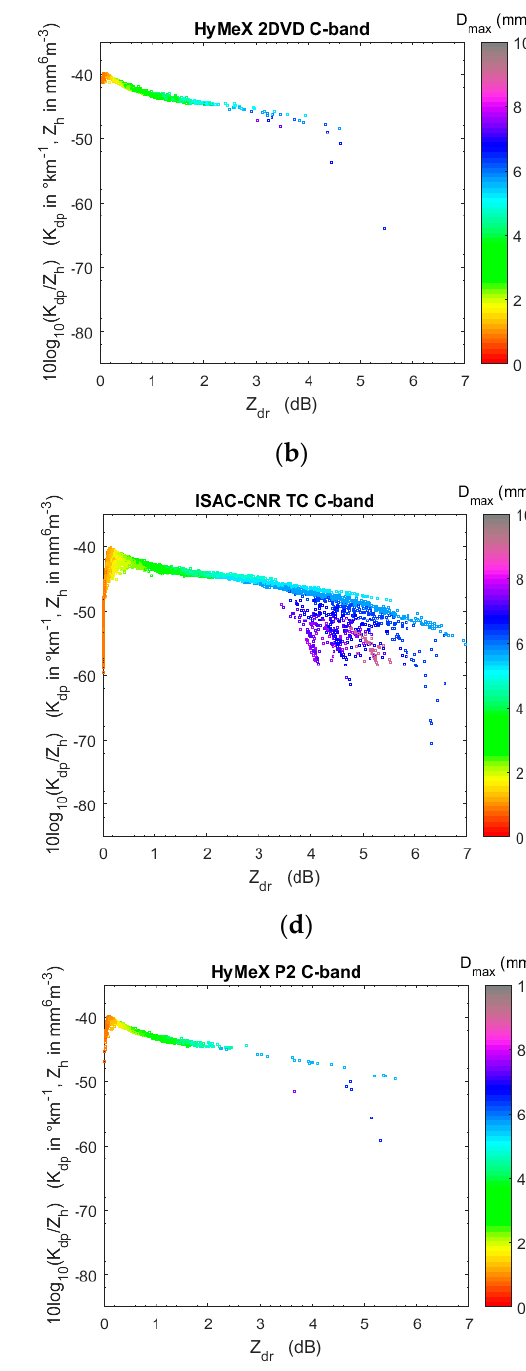
Figure 2. Scatterplot between the ratio K dp /Z h as function of Z dr at S-band for the different datasets considered in this study. The colorbar indicates the values of the measured maximum drop diameter ( D max ). ( a ) IFloodS 2DVD dataset; ( b ) HyMeX 2DVD dataset; ( c ) ISAC-CNR P1 dataset; ( d ) ISAC-CNR